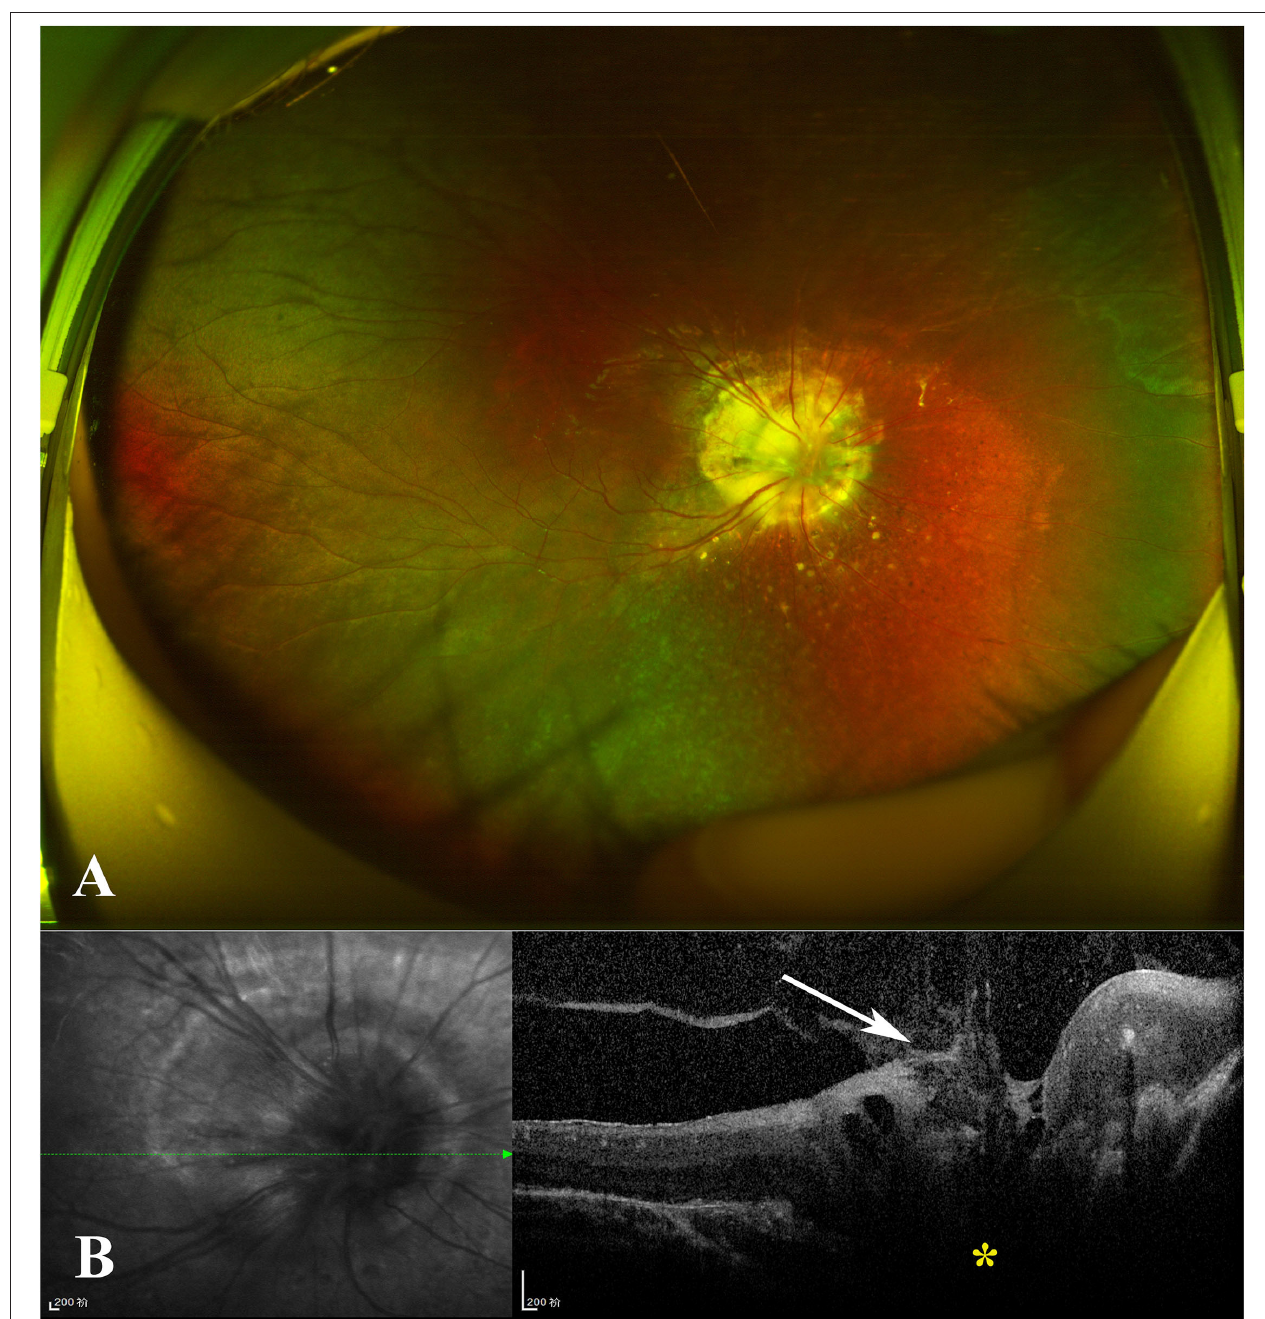
FIGURE 1 | (A) Widefield color fundus photograph of the right eye revealed a large optic disc centrally covered with glial tissue and encircled with chorioretinal pigmentary disturbance, as well as straight retinal vessels radially issuing from the disc margin with increased numbers. (B) Spectral-domain optical coherence tomography (SD-OCT) revealed the conical excavation of the optic disc (yellow star) with a central tuft of glial tissue on top (white arrow).